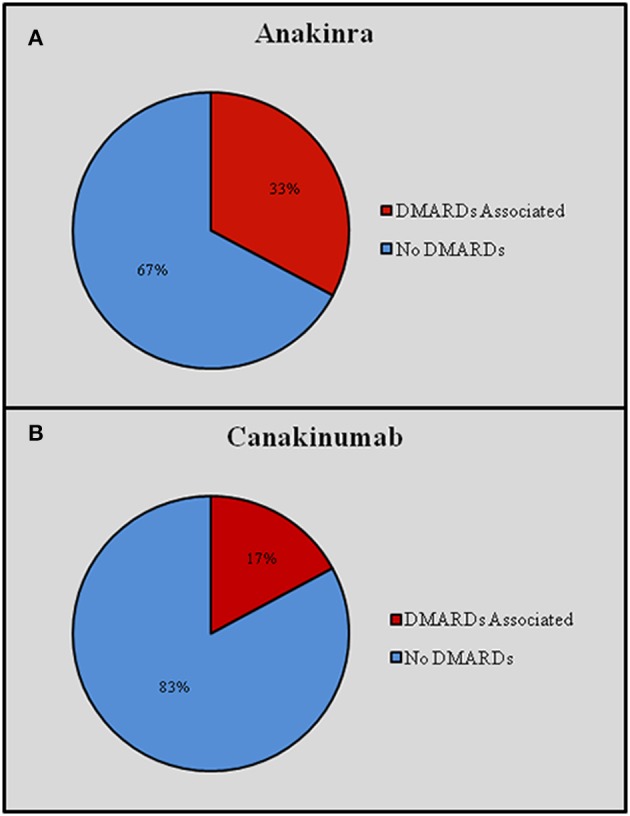
Frequency of disease modifying antirheumatic drugs (DMARDs) concomitantly administered with Anakinra (A) and Canakinumab (B). DMARDs, disease modifying antirheumatic drugs.